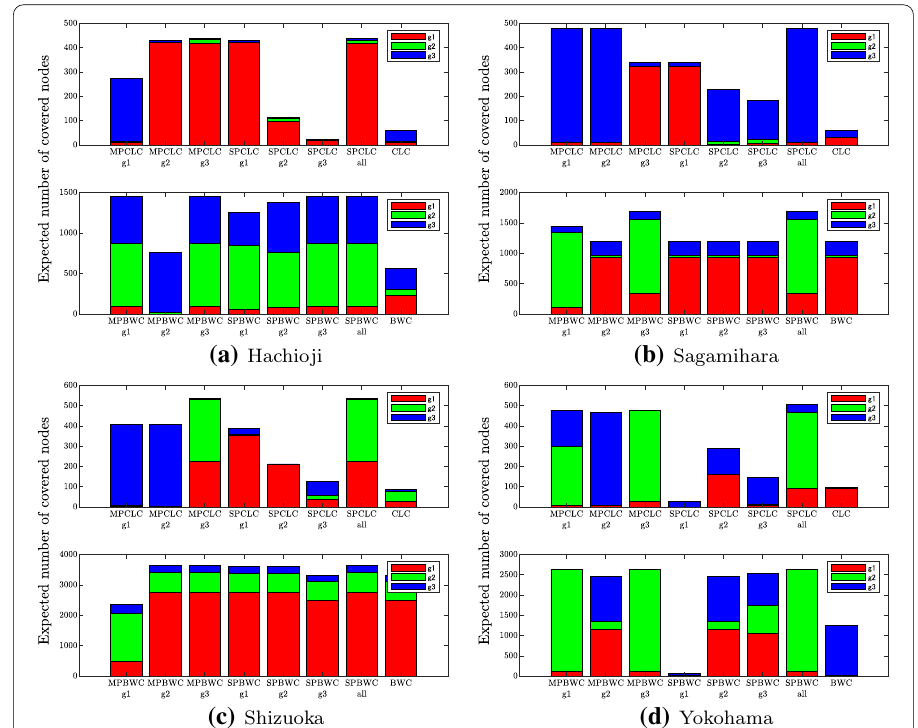
Fig. 3 Expected number of covered nodes and their breakdown. Each bar shows the expected number of covered nodes and their breakdown (g1: red, g2: green, and g3: blue) when a store is opened at the node extracted by each method: the three leftmost bars are g ( ˆ x 1 ) , g ( ˆ x 2 ) and g ( ˆ x 3 ) , respectively, which are obtained by the multiple perspective group centrality (proposed method) against each group; the next three bars are g ( ˆ y 1 ) , g ( ˆ y 2 ) and g ( ˆ y 3 ) , respectively, which are obtained by the single perspective group centrality (existing method) against each group; the second rightmost bar is g ( ˆ y ) , which is obtained by the existing method against one group where all groups are mixed up; and the rightmost bar is g ( ˆ z ) , which is obtained by the classical